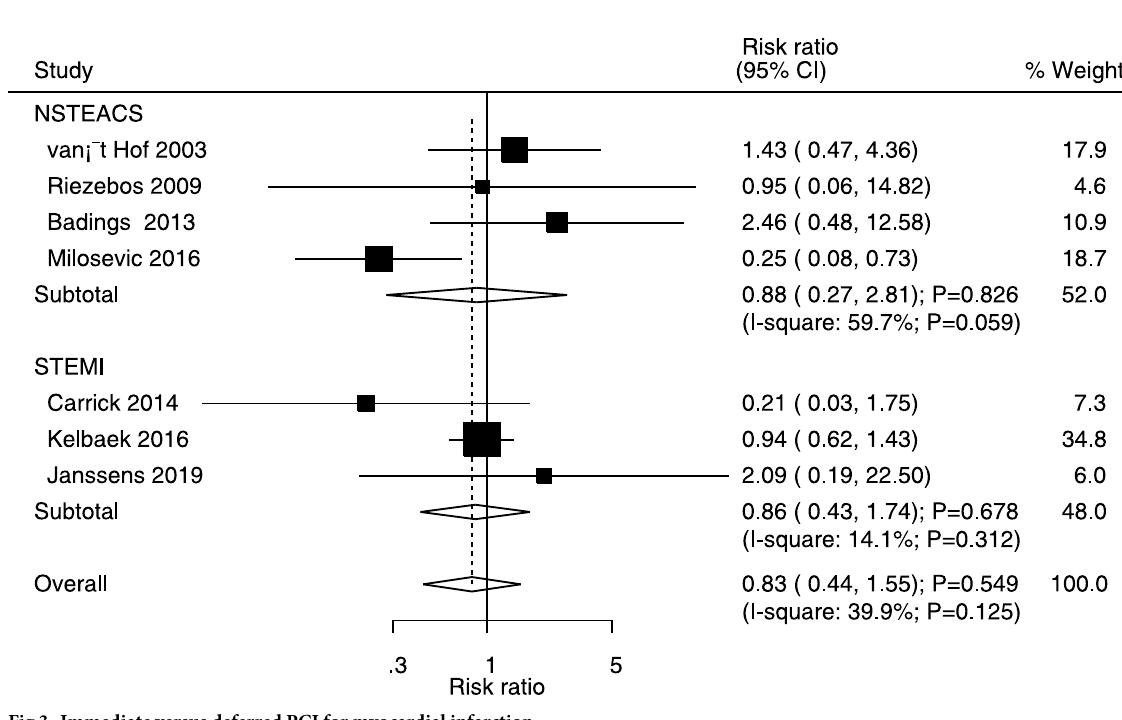
Fig 3. Immediate versus deferred PCI for myocardial